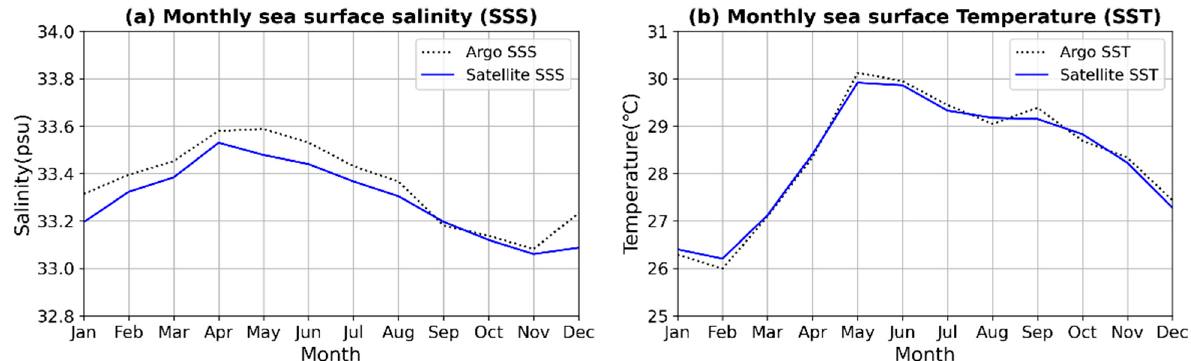
Figure 4. Comparison of the Argo (dashed black line) and satellite (solid blue line) for ( a ) the monthly mean SSS and ( b ) SST in the SCS from January 2010 to December 2019.